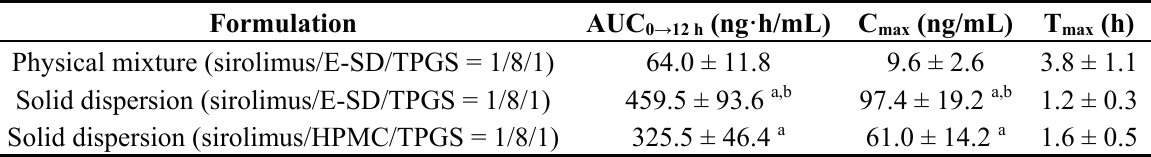
Table 3. Pharmacokinetic parameters of sirolimus-loaded solid dispersions in rats.